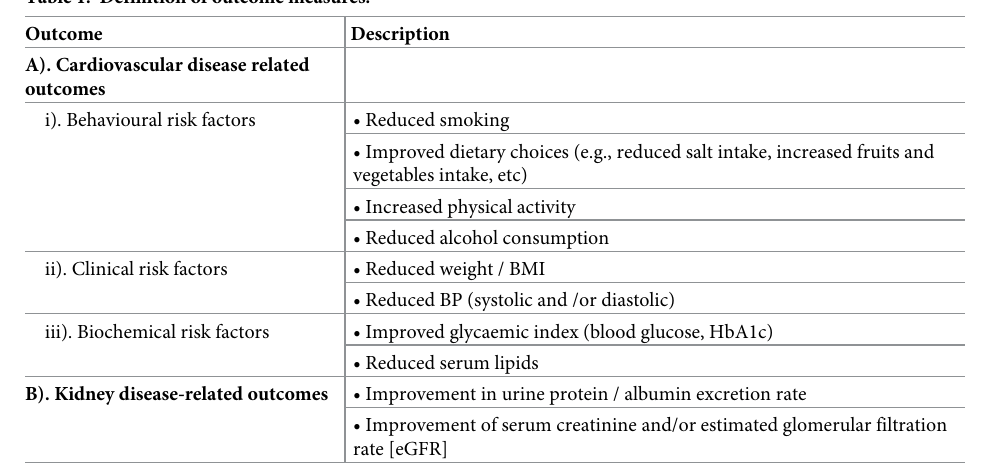
Table 1. Definition of outcome